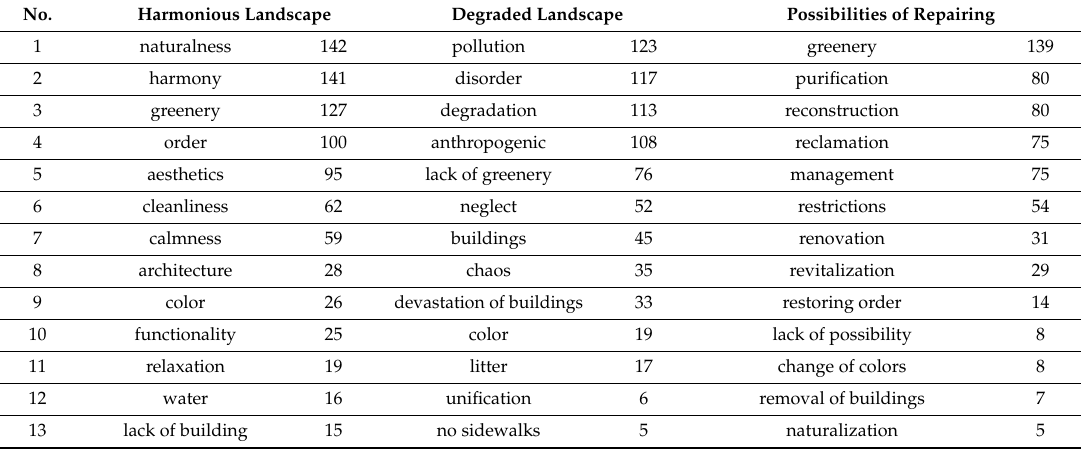
Table 3. Number of people who mentioned individual landscape characteristics and methods for improving the degraded landscape (EnvEng and CivEng students combined, n =